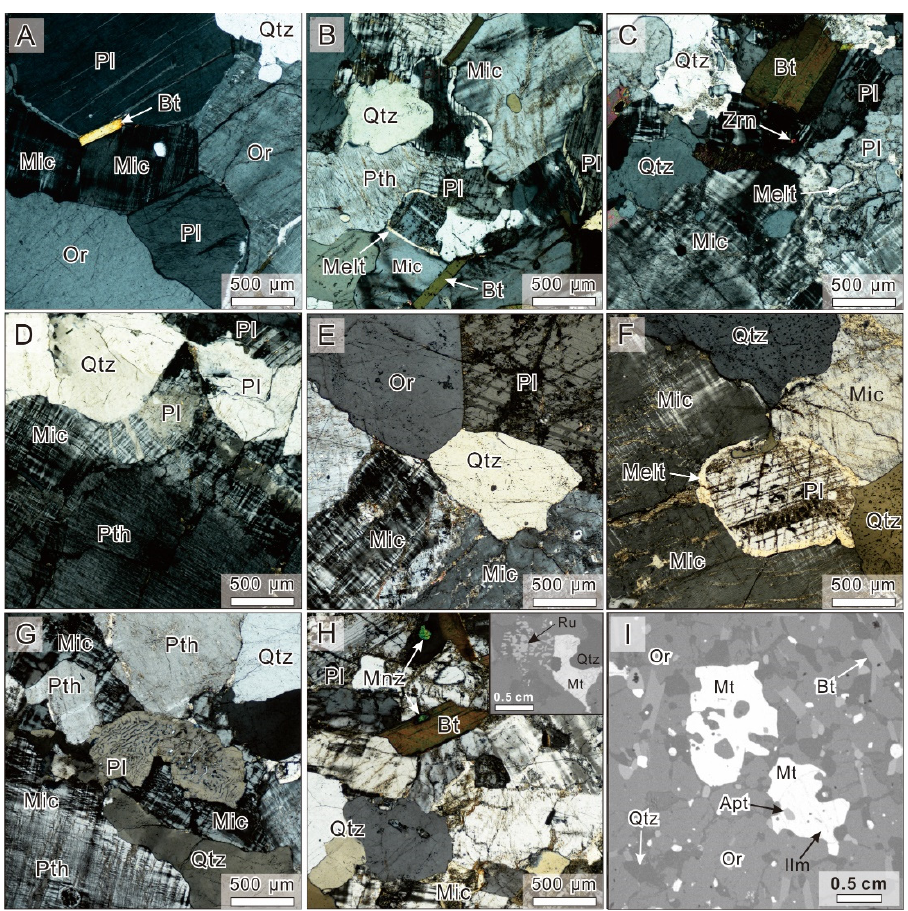
Figure 3. Representative photomicrographs of the AMC. ( A – C ) Biotite granitic gneiss; ( D – G ) sye- no-granitic pegmatite; ( H ) syeno-granitic gneiss; ( I ) biotite quartz monzonite. ( A – H ) are cross-polarized light photos, and inset photo in ( H , I ) are backscattered photomicrographs. Mineral ab-